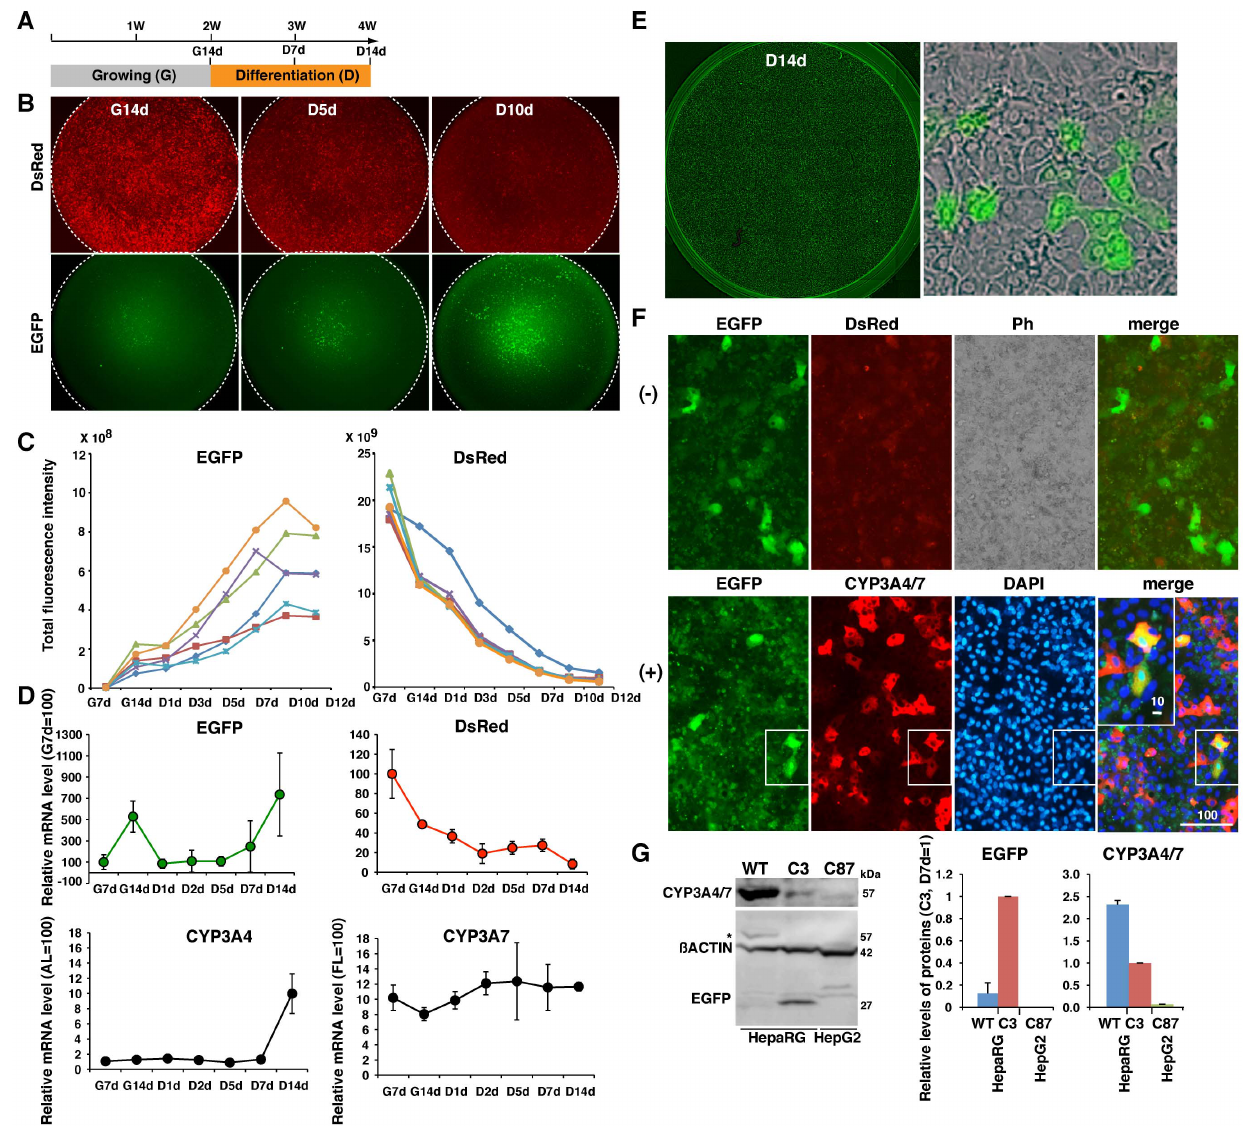
Figure 4. Real-time monitoring of CYP3A4 expression in differentiated transgenic HepaRG cells according to EGFP fluorescence. (A) Strategy for hepatic differentiation of HepaRG cells in vitro . (B) Images of DsRed and EGFP in transgenic HepaRG clone 3 cells cultured in a 96-well plate at G14d, and after 5 days (D5d) and 10 days (D10d) of differentiation culturing. (C) Total fluorescence intensities of EGFP or DsRed in each of 6 wells during the culture of cells that have undergone 7 days of growing (G7d) until D12d. The different colored lines denote different wells. (D) qRT- PCR analyses showing the mRNA levels of EGFP, DsRed, endogenous CYP3A4, and endogenous CYP3A7 in HepaRG cells from G7d to D12d. The mean 6 SD of three independent cultures were calculated, and the mRNA levels in cells relative to those in AL or FL (set at 100) are shown. (E) The morphology of EGFP-positive HepaRG cells at D14d is distinct from that of the other large flat cells. (F) Immunostaining of HepaRG C3 cells for anti- CYP3A4/7 antibody at D14d. (-) and ( + ) show cells before and after immunostaining, respectively. The scale bar is 100 m m in the image and 10 m m in the inset. Ph: phase-contrast images. (G) Western blot analysis of CYP3A4/7 and EGFP in HepaRG WT cells, HepaRG C3 cells, and HepG2 C87 cells. Signal intensities are shown relative to those in HepaRG C3 cells at D7d (set at 1).